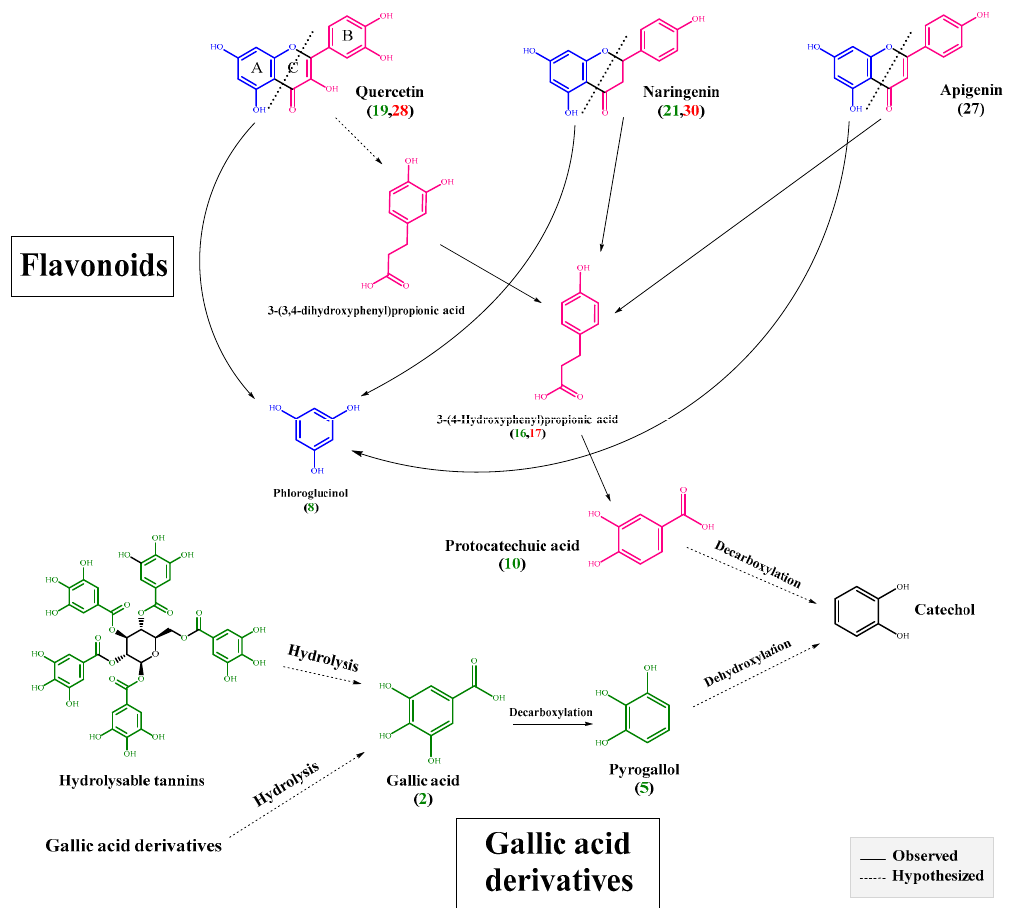
Figure 3. Proposed biotransformation pathways of flavonoids (red and blue) and gallic acid derivatives (green) in O. opuntia, (number) peak number of metabolites; green in in vitro assay and red in ex-vivo assay as presented in Table 1 and Supplementary Table